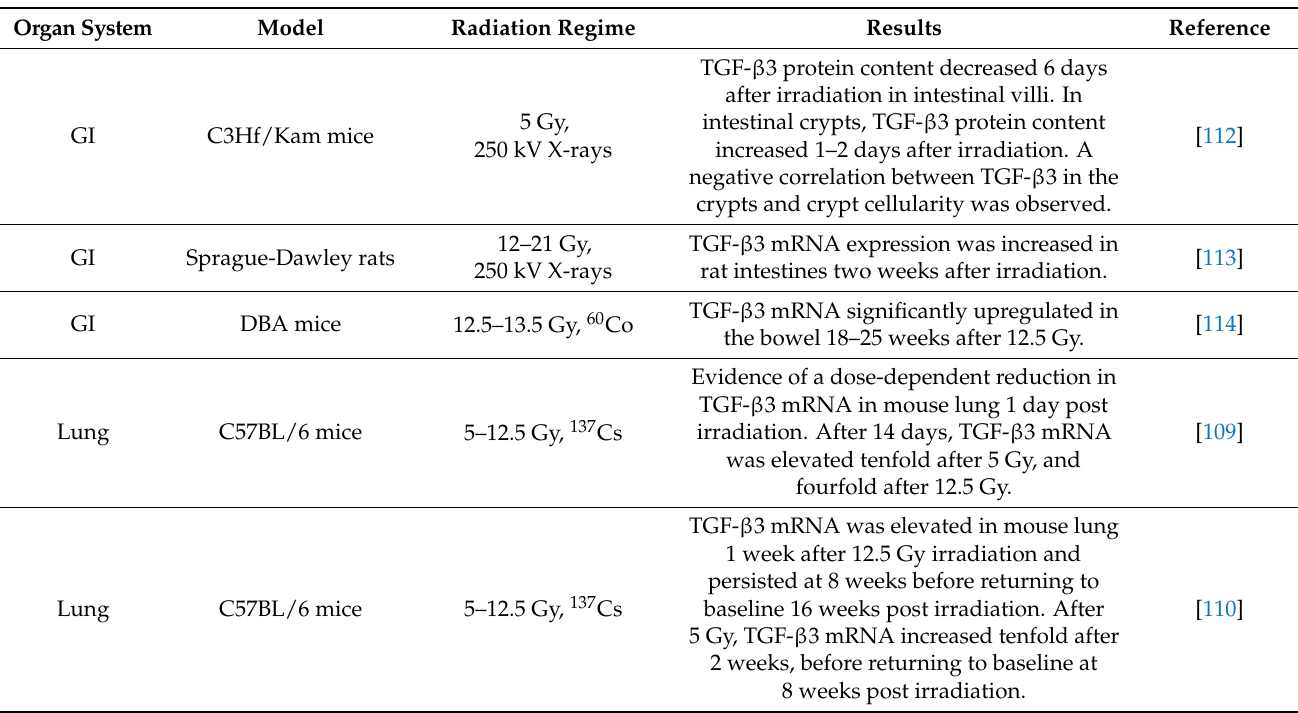
Table 2. Studies of endogenous TGF- β 3 expression after irradiation in vivo. GI: